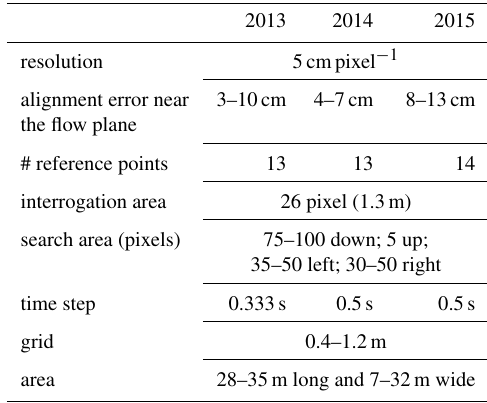
Table 1. LSPIV parameters used for the 2013, 2014, and 2015